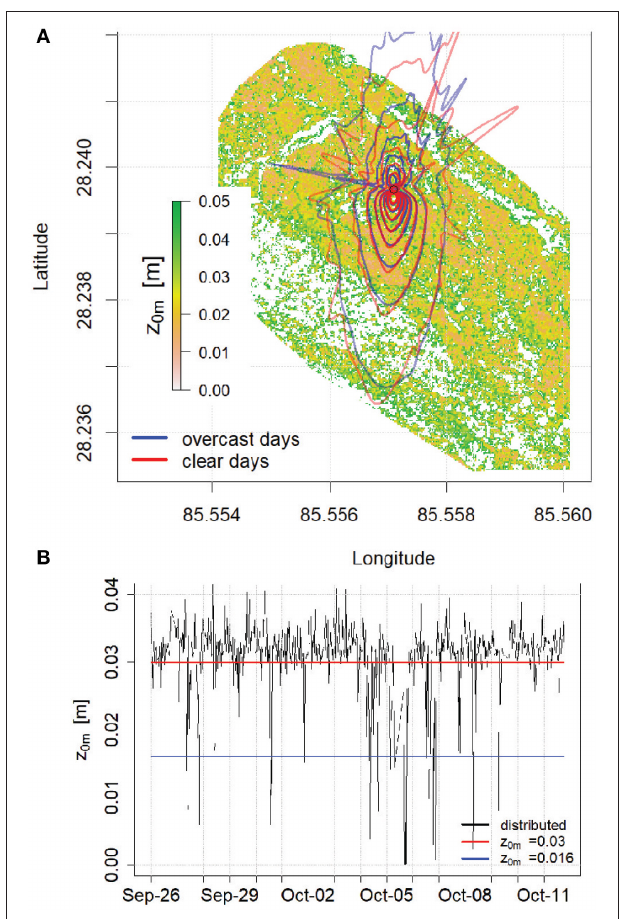
FIGURE 7 | (A) Average footprint effective for the eddy correlation measurements visualized as contour lines for overcast and clear days during the study period. The contour lines delineate the 10–80 % of the footprint area. Footprints outside the DEM domain are treated as NA. In the background the spatially distributed z 0 m is shown. (B) Time series of z 0 m obtained from the respective footprints (black) for each time step as well as the constant value used in this study (0.03, red) and in Brock et al. (2010); Reid and Brock (2010)) (0.016,